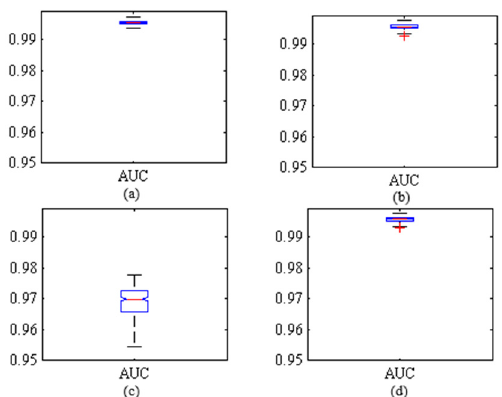
Figure 2. Boxplots of area under the curve (AUC) obtained by the classifiers for the 500 iterations on test data. ( a ) Hybrid ANN ‐ BA; ( b ) Hybrid ANN ‐ BBO; ( c ) Hybrid ANN ‐ FA; ( d ) Voting method.